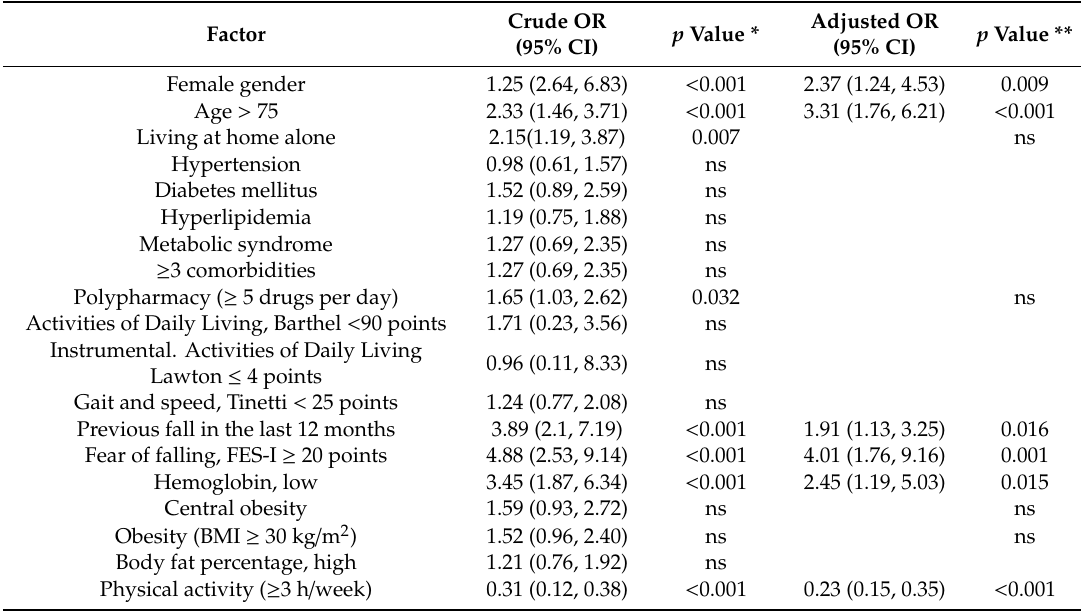
Table 4. Odds ratios and 95% confidence intervals from bivariate analysis and multivariate logistic regression analysis of risk factors related to